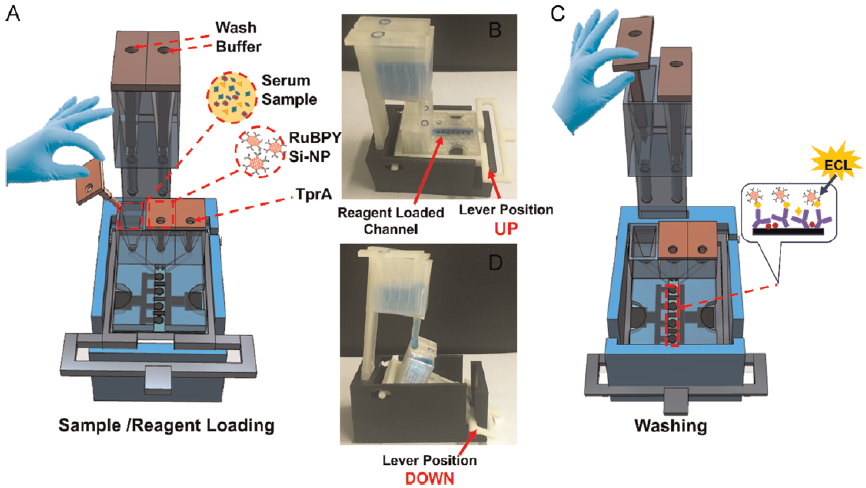
Figure 25. FFF ‐ made immunosensor device [23]. A: Removal of insert for sample delivery from reservoir by gravity flow. B: Blue ‐ color solution fills the horizontal detection channel with lever up. C: Buffer delivery from wash reservoir to detection channel in order to wash away unbound proteins. D: Blue ‐ color solution is delivered from wash reservoir to main array when lever is down. (Reproduced with permission from [23].)